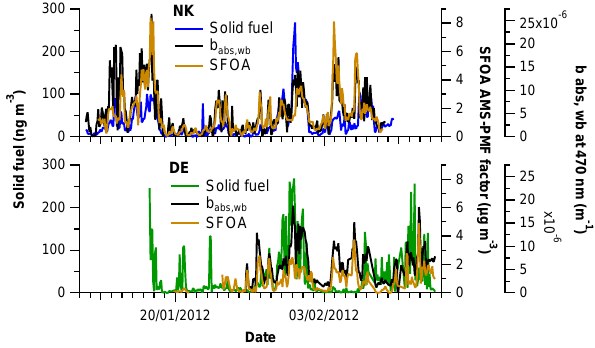
Figure 13. Time series of the solid fuel factor at NK and DE com- pared to the Aethalometer wood burning absorption coefficient at wavelength 470nm ( b abs , wb at 470nm) and to the solid fuel organic aerosol (SFOA) factors resolved with